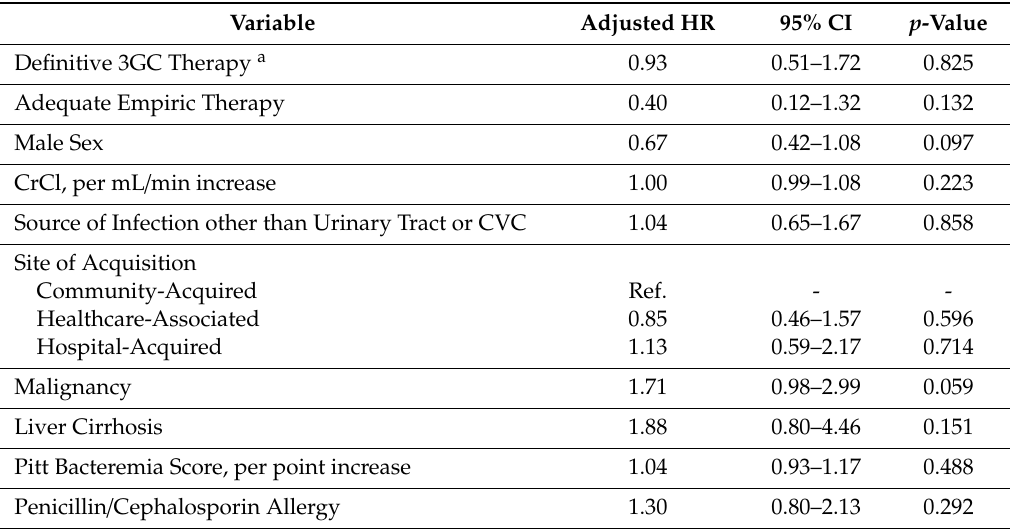
Table 5. Multivariable Cox proportional hazards regression model for overall treatment